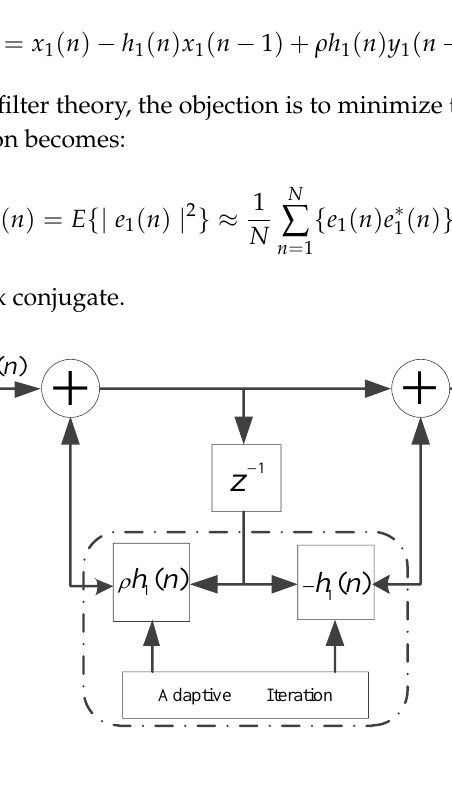
Figure 2. Implementation of the one order complex-coefficient notch filter unit with a single constrained zero-pole